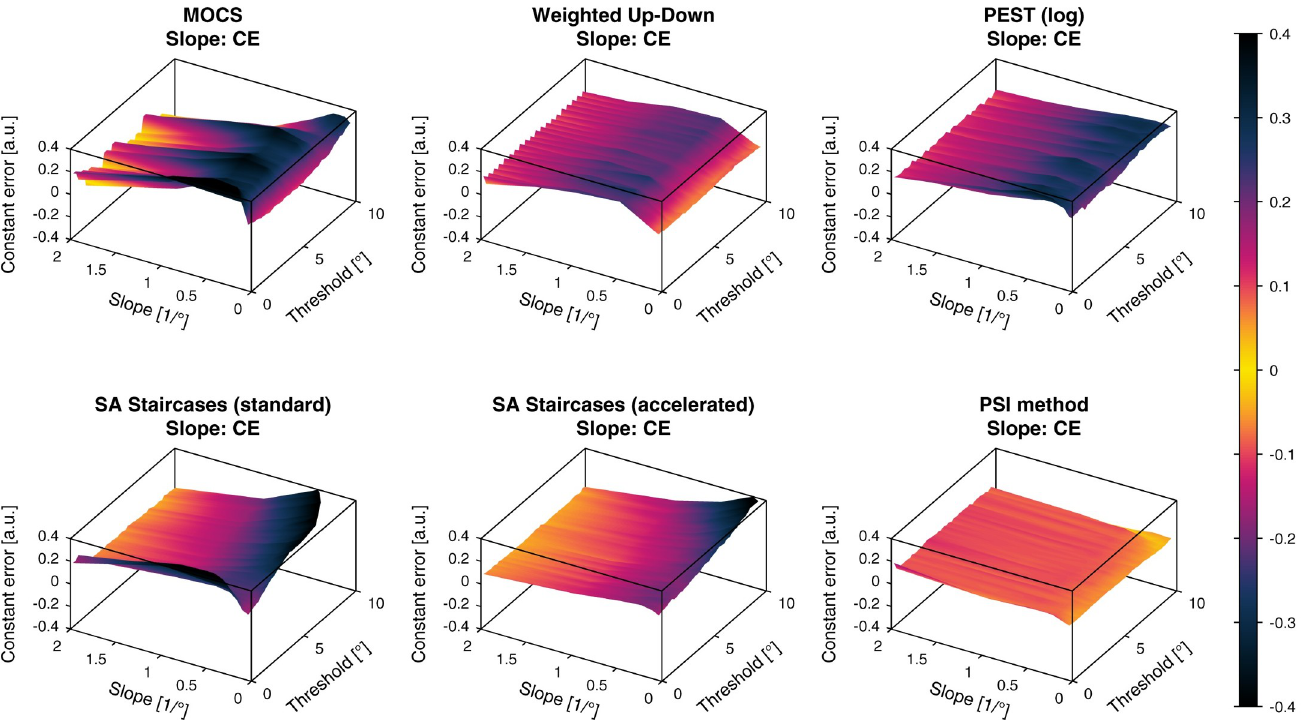
Fig 8. Constant errors of slope estimates. Constant errors ( CE ) of the slope estimates for the six different simulated sampling procedures. The color bar indicated the CE values in (a.u.).